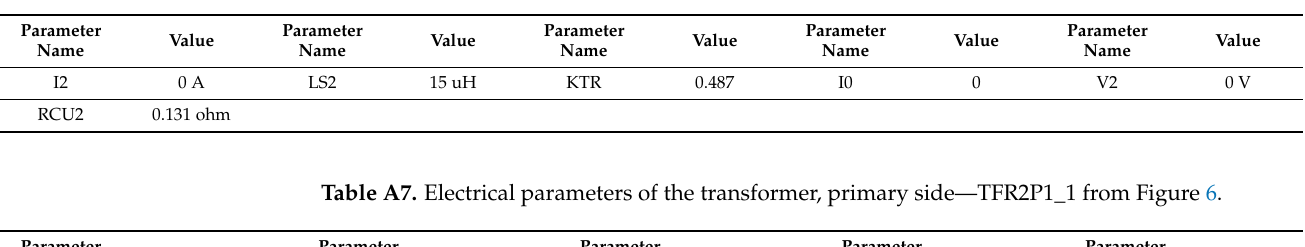
Table A6. Electrical parameters of the transformer, secondary side—TFR1P2_n from Figure 6.